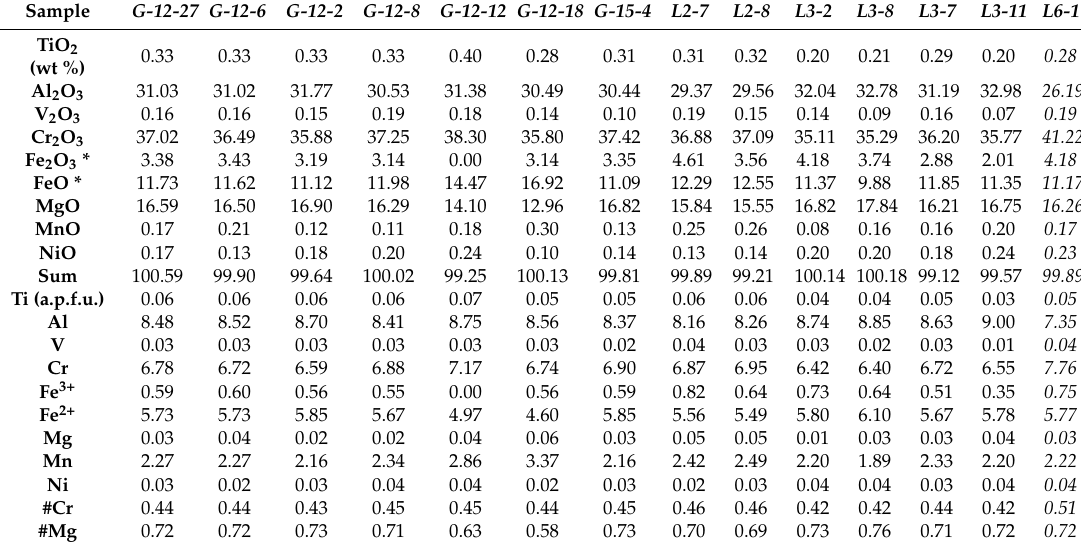
Table 1. Representative electron microprobe analyses of chromite from the Mercedita mine.